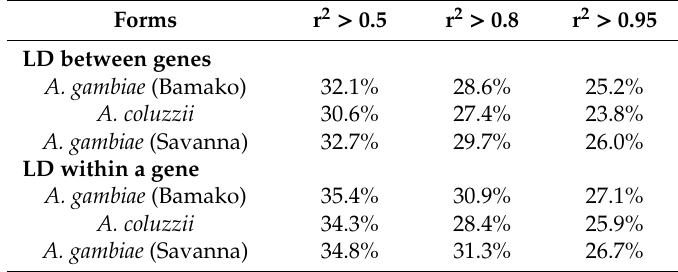
Table 3. Proportions of potentially functional SNP pairs where linkage disequilibrium (LD; r 2 ) exceeds 0.5, 0.8, and 0.95 thresholds based on population-scale genotype data.